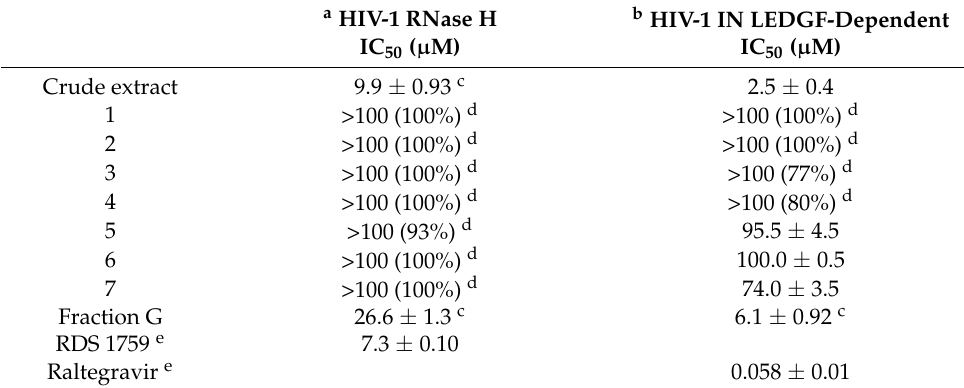
Table 2. Anti-HIV activity of crude extract, pure compounds, and fraction G.